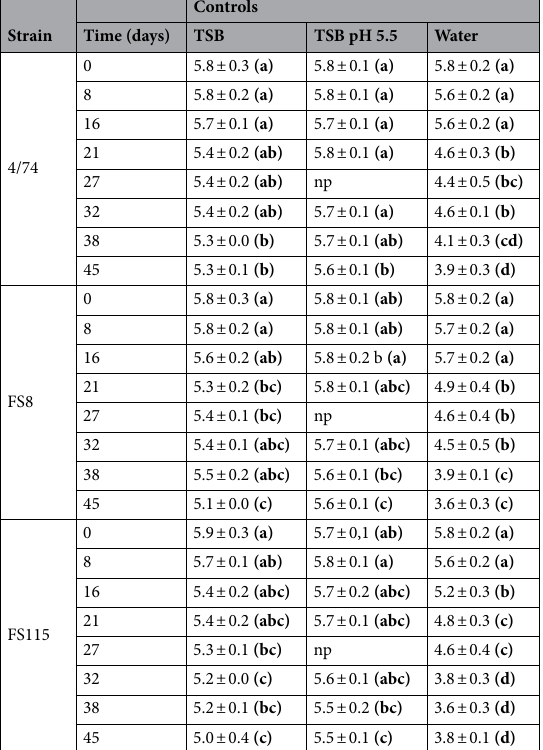
Table 3. In vitro effect of controls (TSB, TSB adjusted to pH 5.5 and de-ionized water) in S. Typhimurium 4/74, FS8 and FS115 incubated at 4 °C. Each data point is a mean of at least 6 replicates (± standard deviation). Different lowercase letters within each column of the same strain indicate statistical differences ( P < 0.05) during incubation at 4 °C according to Tukey’s HSD. np: not